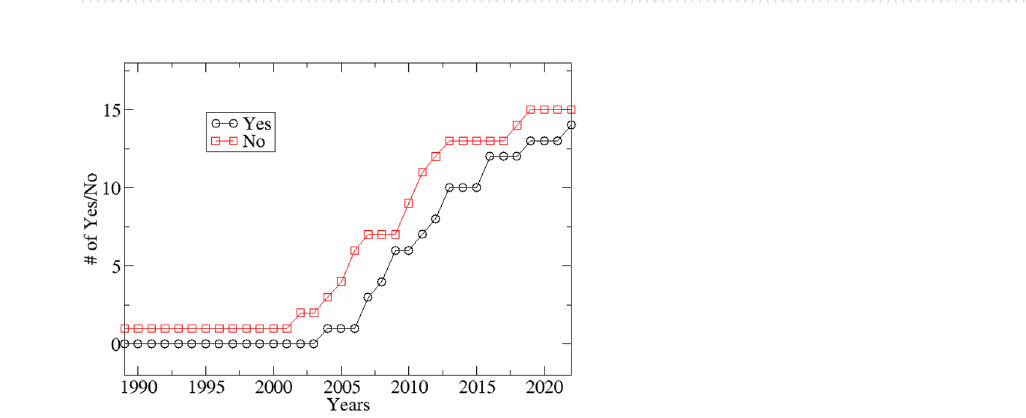
Figure 2. Time course of the percentage of studies that accept the existence of the correlation between magnitude.